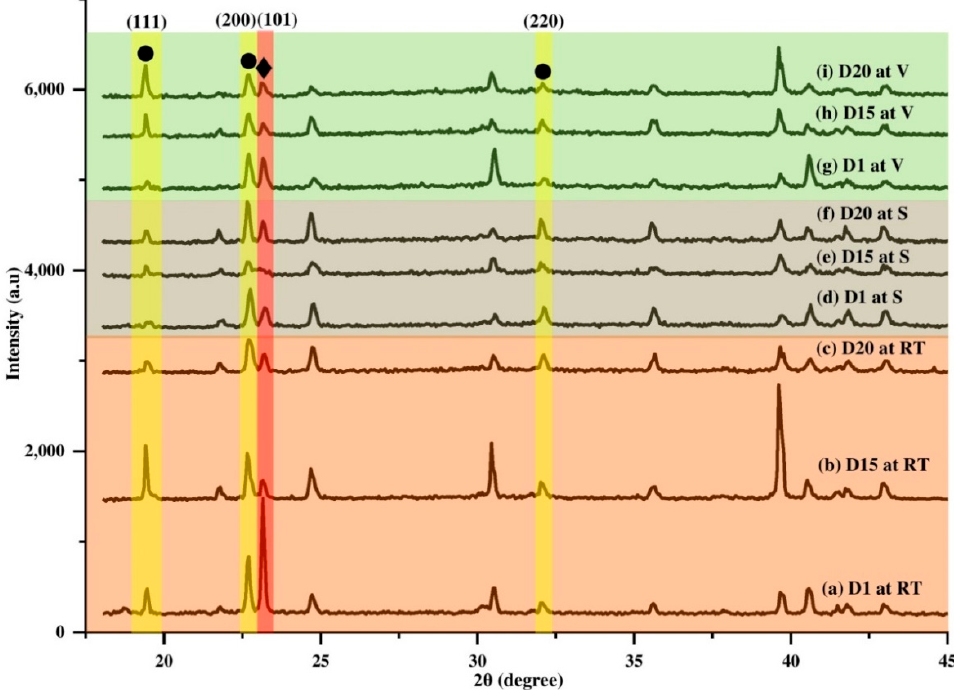
Figure 9. XRD spectrum of N ‐ AMP with ♦ marking the peak of perovskite (101) and ● marking those of Pb(NO 3 ) 2 (111) (200) (220).